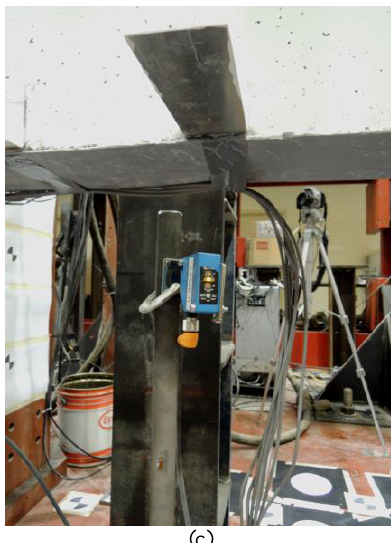
Figure 1. Overview of the experiment setup (a), the hydraulic actuator and concrete beam (b), and close-up of one of the thirteen offset/witness plates with a control laser transducer installed underneath it (c)